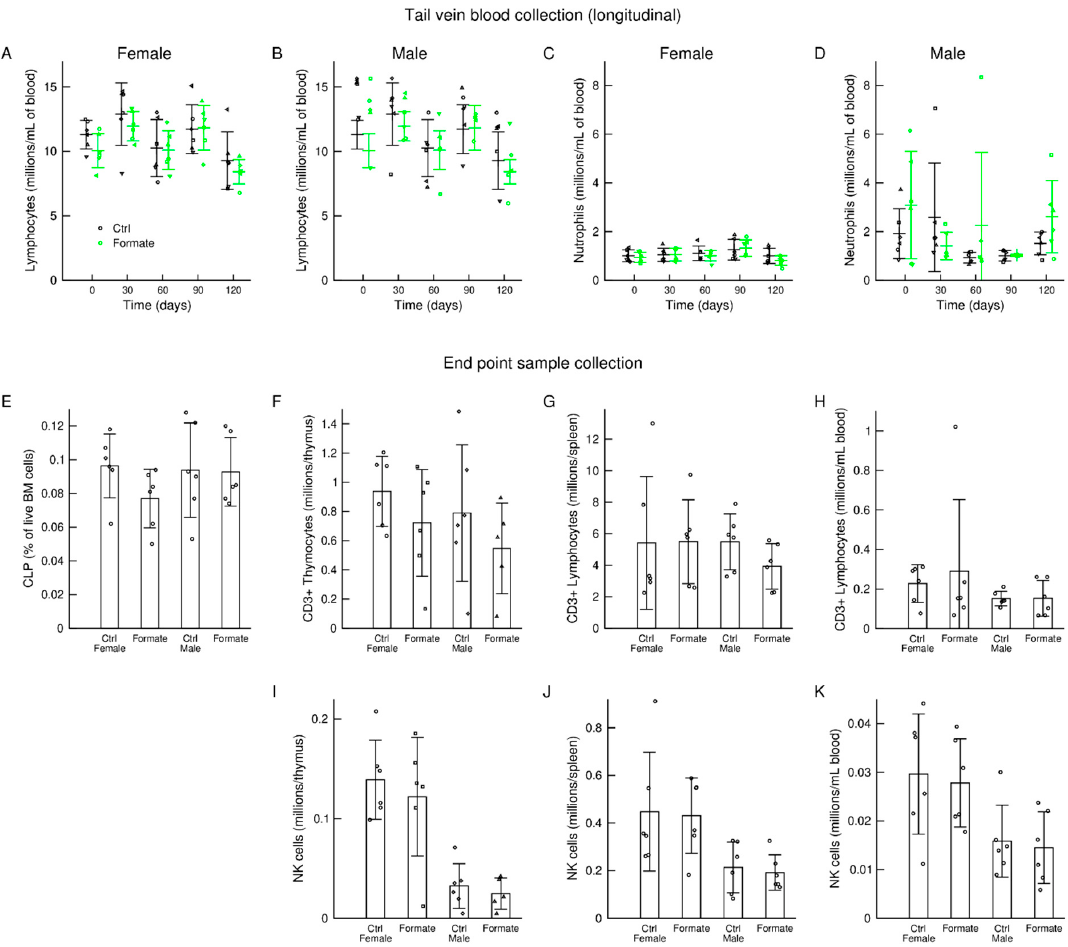
Figure 3. Immune system characterization. ( A – D ) Longitudinal counts of immune system subpopulations in blood samples from the tail vein. ( E – K ) Immune cell counts from samples at the end of the study. Statistics: Each symbol represents an individual mouse, the bars heights represent the mean and the error bars the standard deviation.